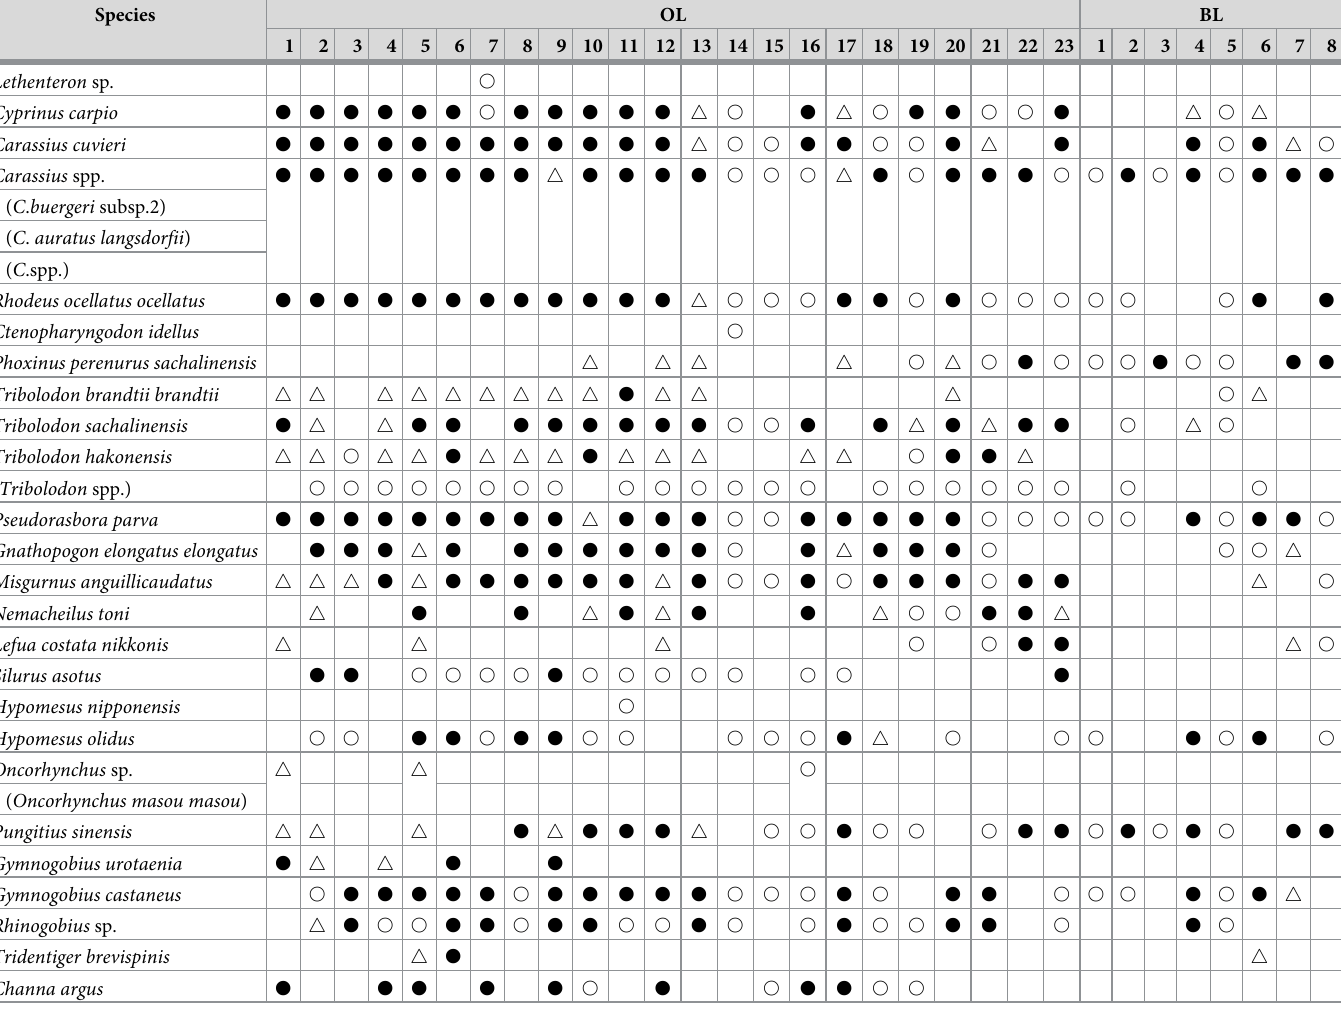
Table 2. Species determined from capture approaches ( ○ ), eDNA metabarcoding ( 4 ), and both methods ( ● ).